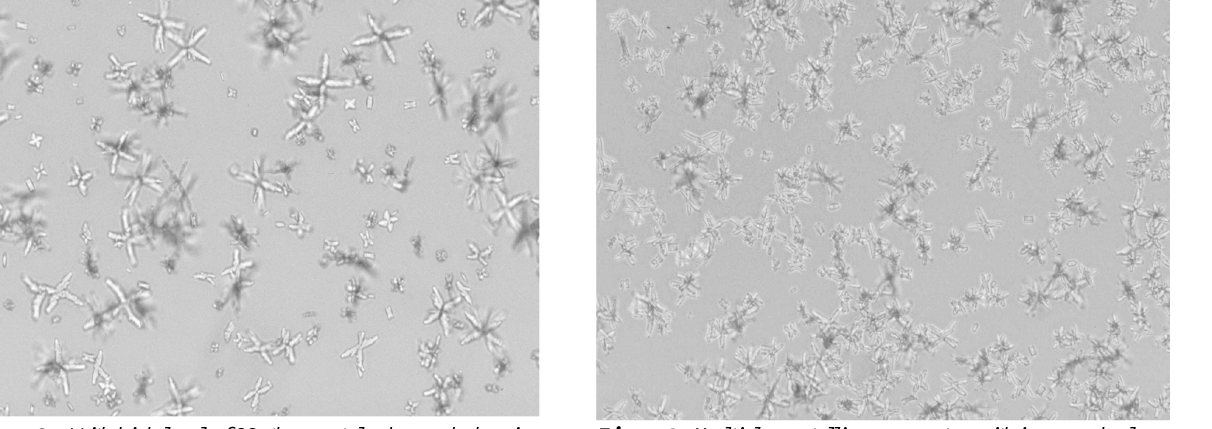
Figure 3 – With high level of SS, the crystals changed, showing X-shaped habit and increased diameter. (500x-magnification)